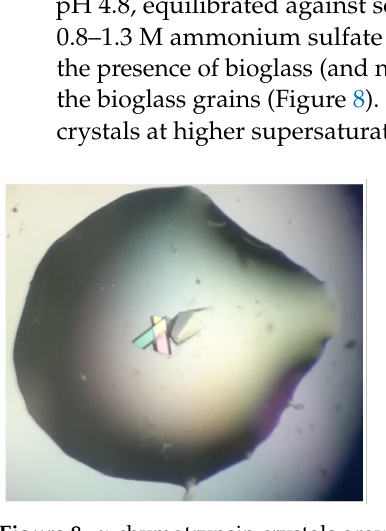
Figure 8. α -chymotrypsin crystals growing on bioglass at metastable conditions (drop volume after equilibration ca. 1 µ L; crystals visible to the left of the bioglass